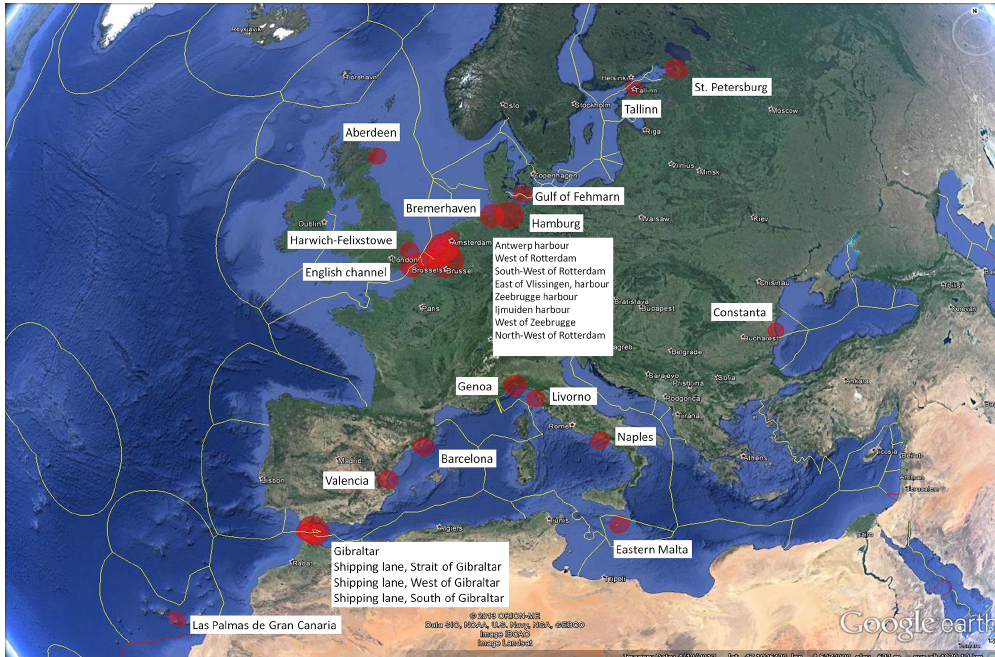
Figure 3. The 30 locations in which there were highest ship emissions of CO 2 in Europe in 2011. The area of each circle is proportional to the annual CO 2 emission.